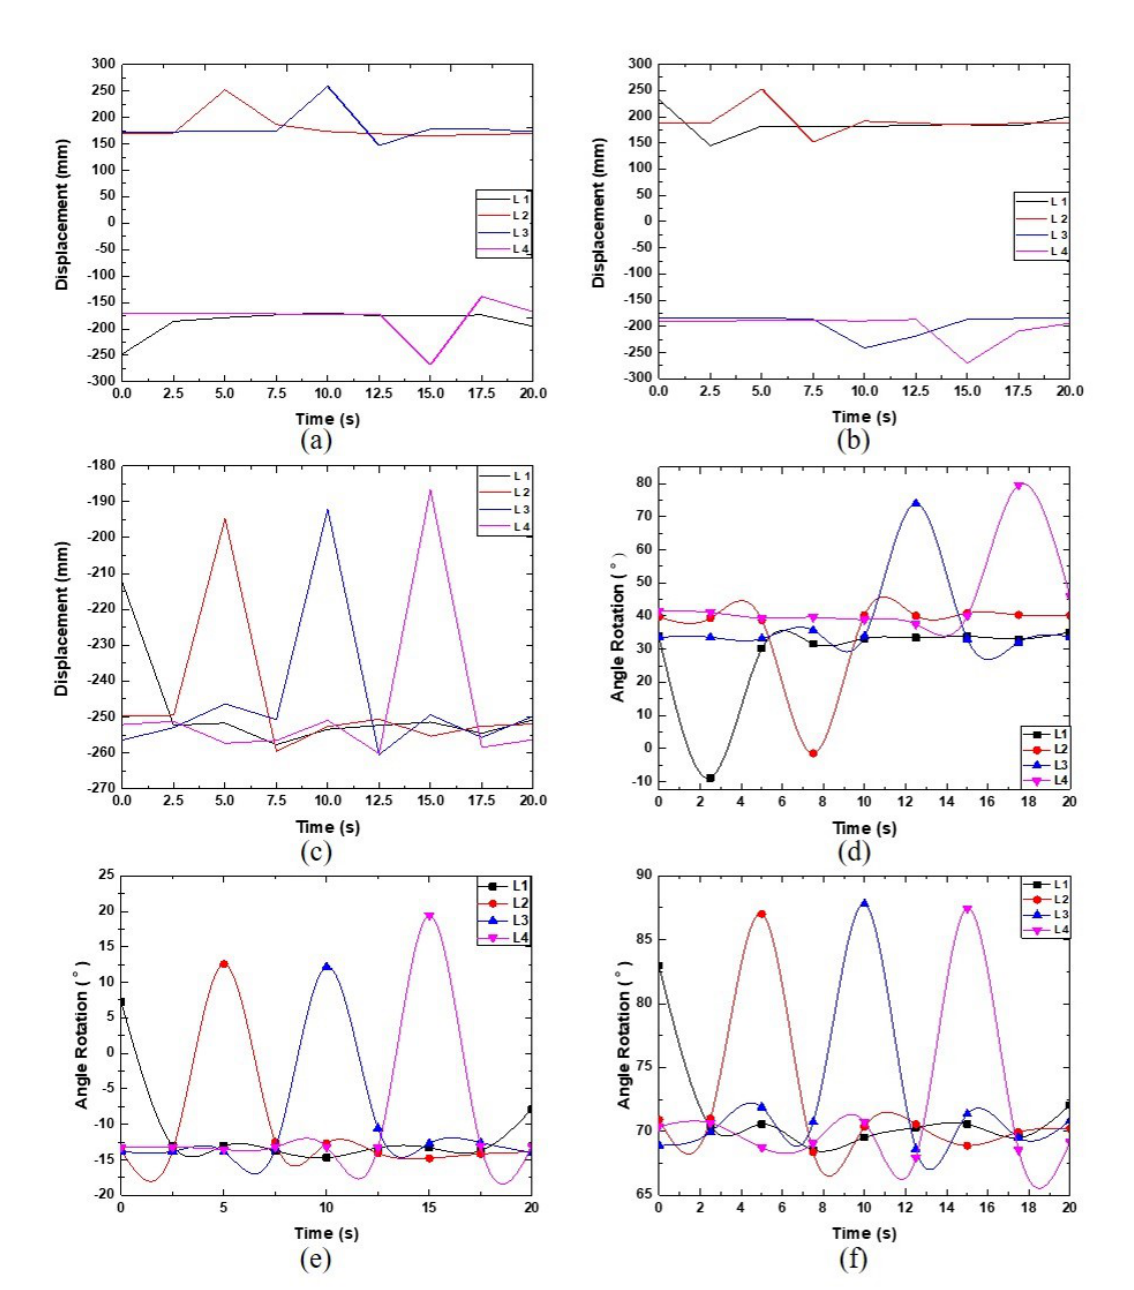
Figure 7. Displacement of the feet trajectory on the walking motion for a single robot along the ( a ) x -axis, ( b ) y -axis, and ( c ) z -axis. The angle of rotation of the leg joints for a single robot: ( d ) Joint 1, ( e ) Joint 2, and ( f ) Joint